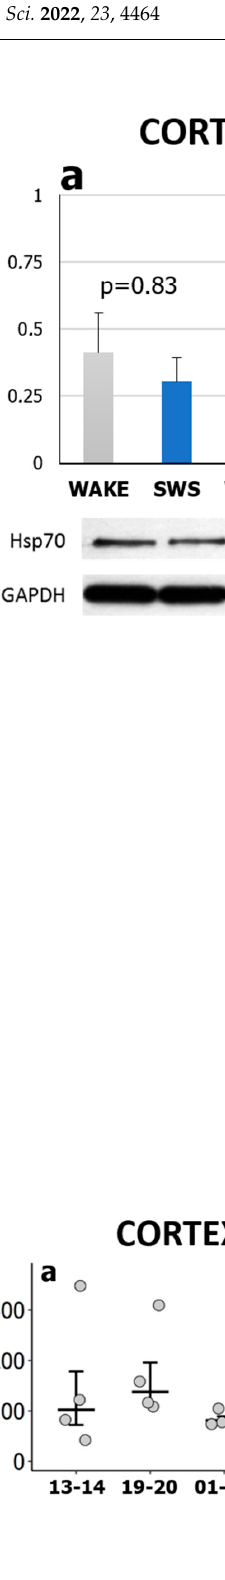
Figure 4. Circadian rhythm has no significant effect on Hspa1 expression within the studied rat brain areas during wakefulness. Relative Hspa1 expression level in ( a ) the sensorimotor cortex, ( b ) the preoptic area of the hypothalamus and ( c ) the nucleus reticularis pontis oralis (NRPO) during wakefulness over the day. To access Hspa1 expression across 24 h, 4 groups of rats were decapitated after 10 min episode of wakefulness at: ZT13-14, ZT19-20, ZT01-02, ZT07-09. The values were calculated using the 2 − ∆∆ Ct method, where the reference group was wakefulness at the beginning of the lights-off (inactive) period (ZT13-14). Each dot represents an independent sample (animal). mboxemphp values were calculated using Kruskal–Wallis H